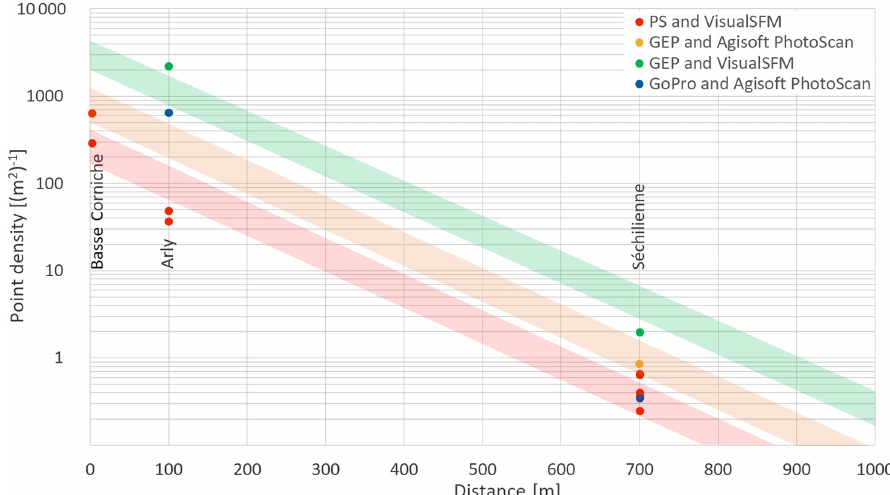
Figure 8. Correlation between the distance from the camera to the case studies and the expected density of points from the three case studies. The red dots are results of the three case studies point clouds obtained from Google Street View (GSV) print screens (PS) in Google Maps (GM) processed with VisualSFM. The red strip represents the corresponding trend based on a negative exponential function. The orange dot is the result of the Séchilienne point cloud obtained from GSV images saved in Google Earth Pro (GEP) processed with VisualSFM. The orange strip represents the corresponding trend based on a negative exponential function. The green dots are the results of the Séchilienne and Arly point clouds obtained from GSV images saved in GEP, processed with Agisoft PhotoScan. The green strip represents the corresponding trend based on a negative exponential function. To compare, the blue dots represent the result of the Séchilienne and Arly point clouds obtained with GoPro action camera images taken on the field and processed with Agisoft